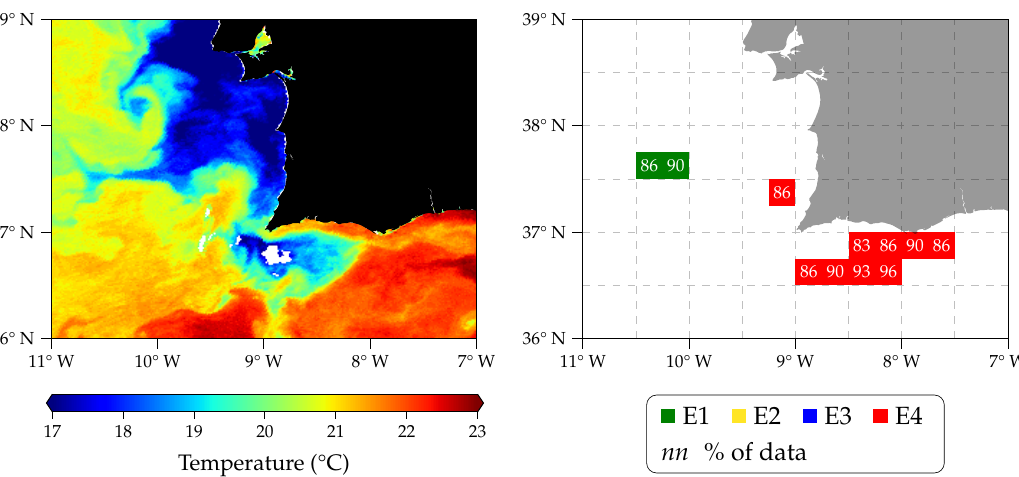
Figure 11. Left : event of 7 October 2017, classified as E4 in the ground truth (but images with events classified as E1 are present around that day in the dataset). Right : heatmap generated by MEC. The figures are cropped to the area between 36° and 39° N and between 11° and 7° W for a better visualisation.